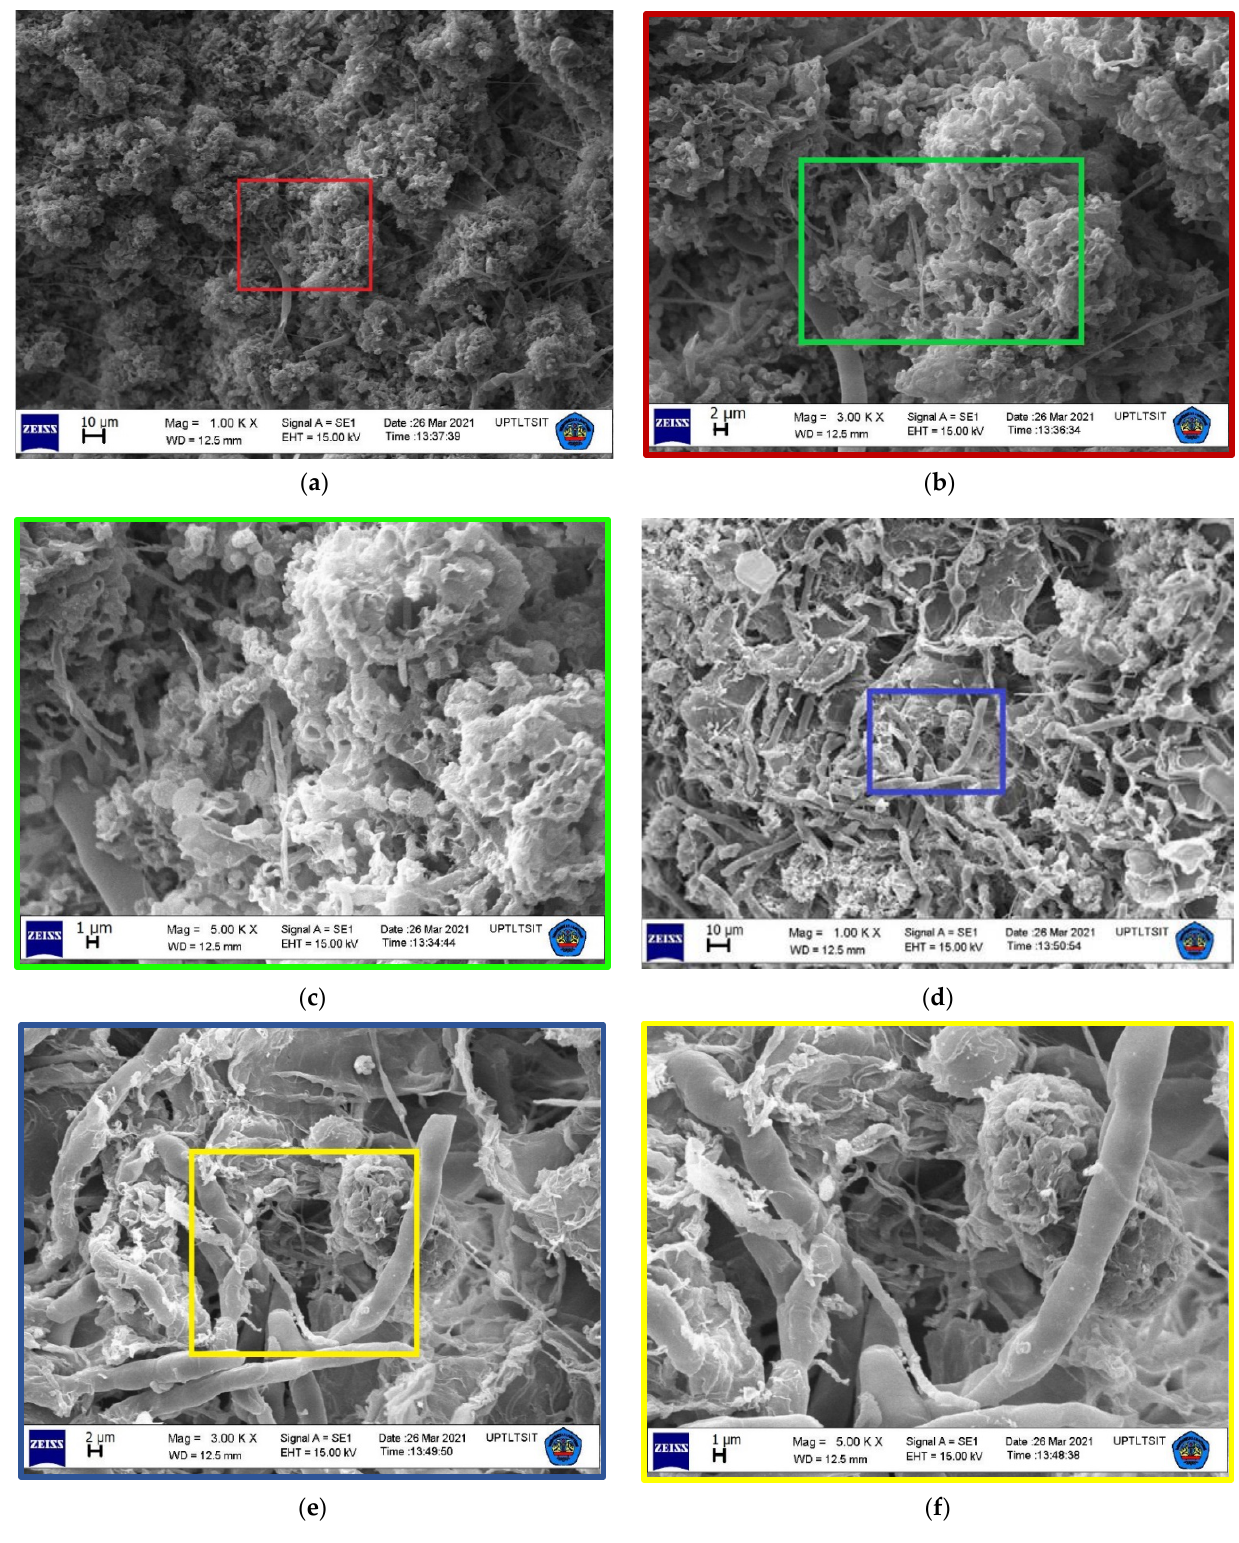
( f ) ( f ) ( f ) Figure 4. SEM micrographs of M. champaca at magnifications of ( a ) 1000, ( b ) 3000, and ( c ) 5000×. Figure 4. SEM micrographs of M. champaca at magnifications of ( a ) 1000, ( b ) 3000, and ( c ) 5000×. Figure 4. SEM micrographs of M. champaca at magnifications of ( a ) 1000, ( b ) 3000, and ( c ) 5000×. Figure 4. SEM micrographs of M. champaca at magnifications of ( a ) 1000, ( b ) 3000, and ( c ) 5000×. Figure 4. SEM micrographs of M. champaca at magnifications of ( a ) 1000, ( b ) 3000, and ( c ) 5000 × . SEM micrographs of S. mahagoni at magnifications of ( d ) 1000, ( e ) 3000, and ( f ) 5000×. The colored SEM micrographs of S. mahagoni at magnifications of ( d ) 1000, ( e ) 3000, and ( f ) 5000×. The colored SEM micrographs of S. mahagoni at magnifications of ( d ) 1000, ( e ) 3000, and ( f ) 5000×. The colored SEM micrographs of S. mahagoni at magnifications of ( d ) 1000, ( e ) 3000, and ( f ) 5000×. The colored SEM micrographs of S. mahagoni at magnifications of ( d ) 1000, ( e ) 3000, and ( f ) 5000 × . The colored ) in a panel depicts the analyzed ) in a panel depicts the analyzed area. ) in a panel depicts the analyzed area. ) in a panel depicts the analyzed area. box ( : , , or ) in a panel depicts the analyzed area. box ( , , , , : : box ( :